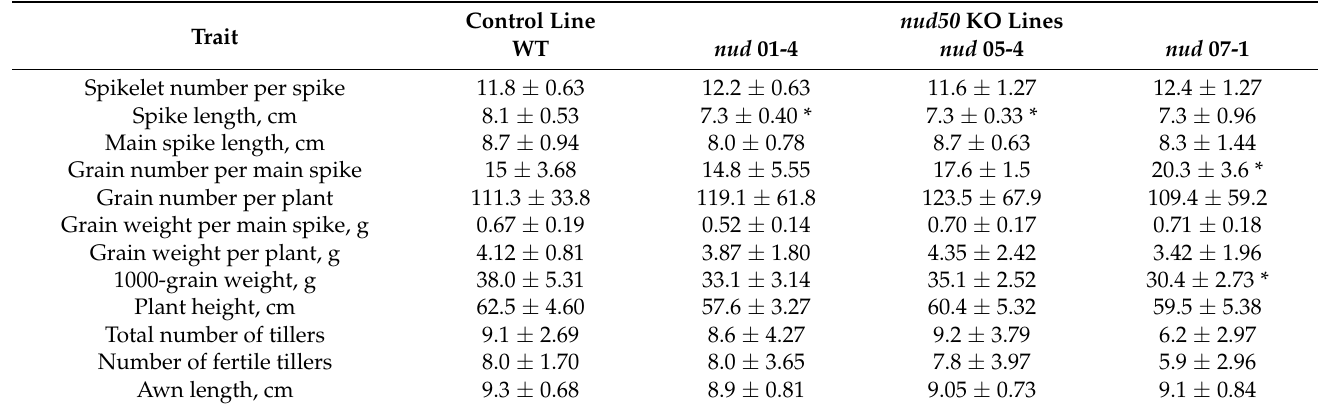
Table 1. General phenotyping of the nud KO lines (mean ± standard